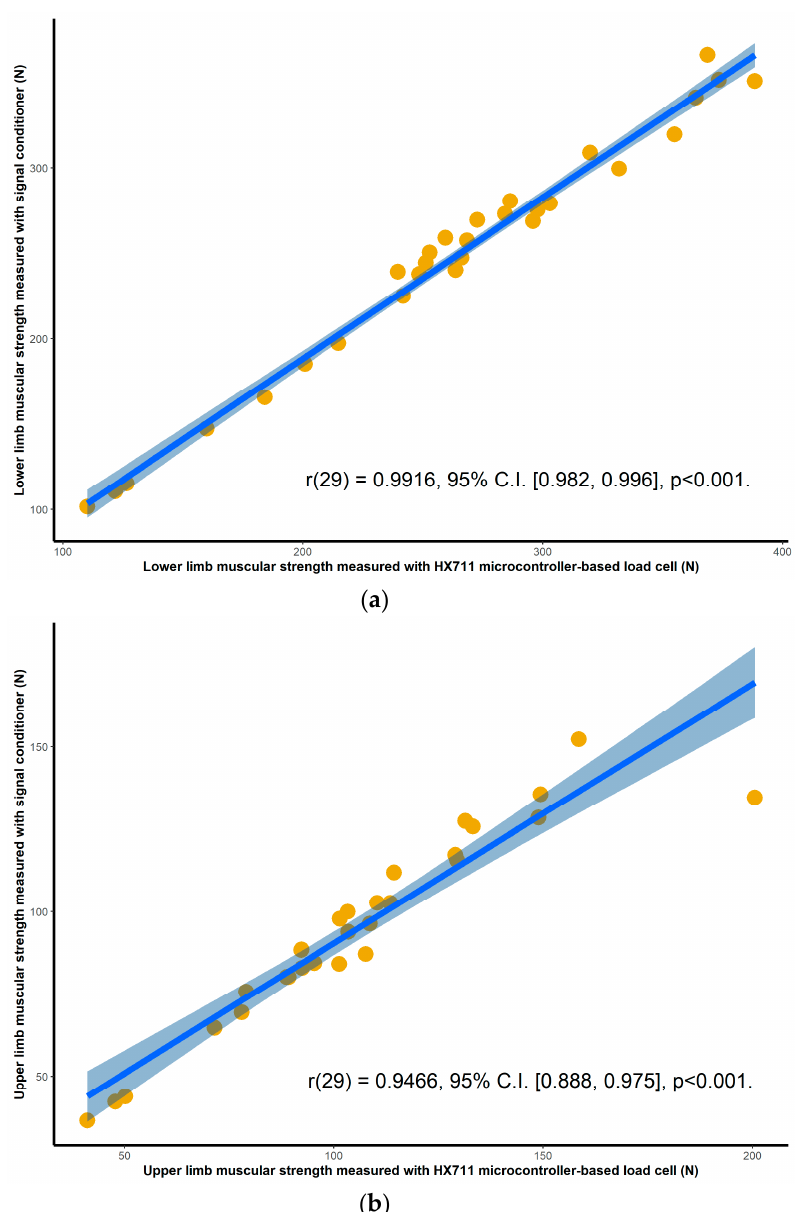
Figure 5. Session two correlations between the commercial signal conditioner and the HX711 microcontroller-based load cell for: ( a ) maximal isometric leg extension; ( b) maximal isometric bicep flexion. The blue line and the shaded area are the linear regression slope and its 95% confidence region.